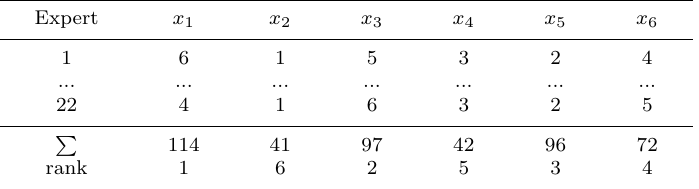
Table 3. Evaluation of criteria x 1 − x 6 priority by 22 experts.